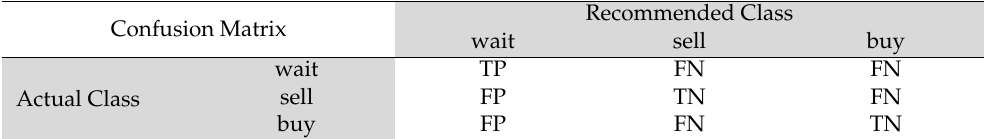
Table 5. Confusion matrix of the proposed